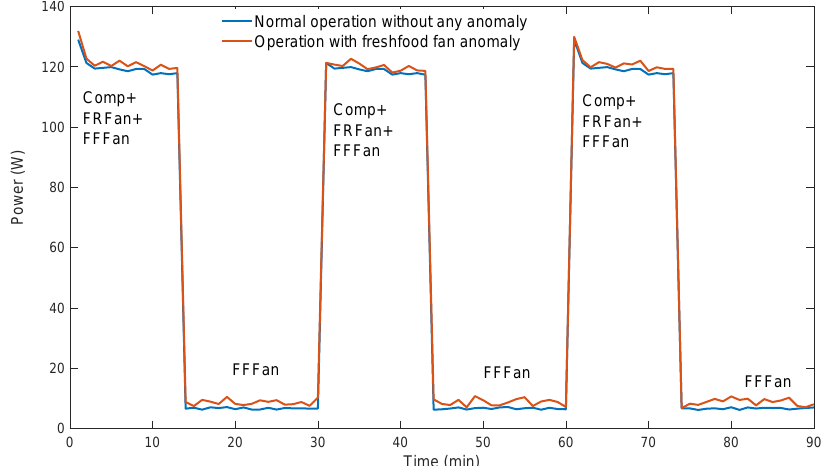
Figure 1. Power profiles of Ref with/without